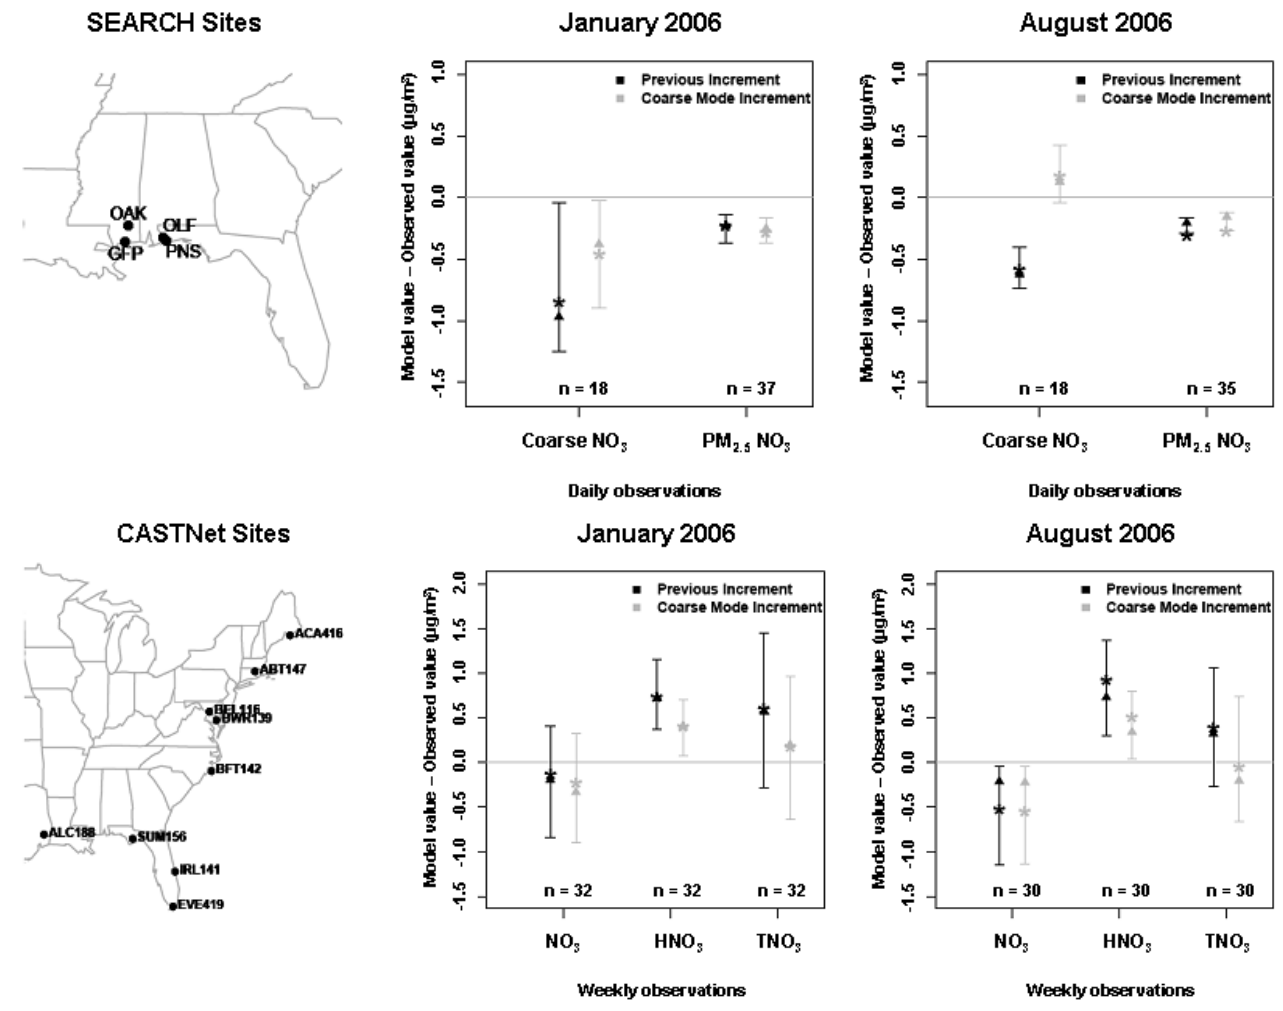
Fig. 6. Mean (star), median (triangle), and inter-quartile ranges of model bias (model value – observed value) for multiple species measured at 9 coastal CASTNet sites and 4 SEARCH sites. The number of model/observation pairs for each species is shown above the